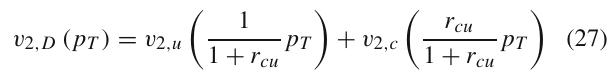
The dashed lines, marked as s ¯ s coal, are results of strange quark anti- quark combination. The solid lines are results considering the mixture of quark combination and two-kaon coalescence. See text for